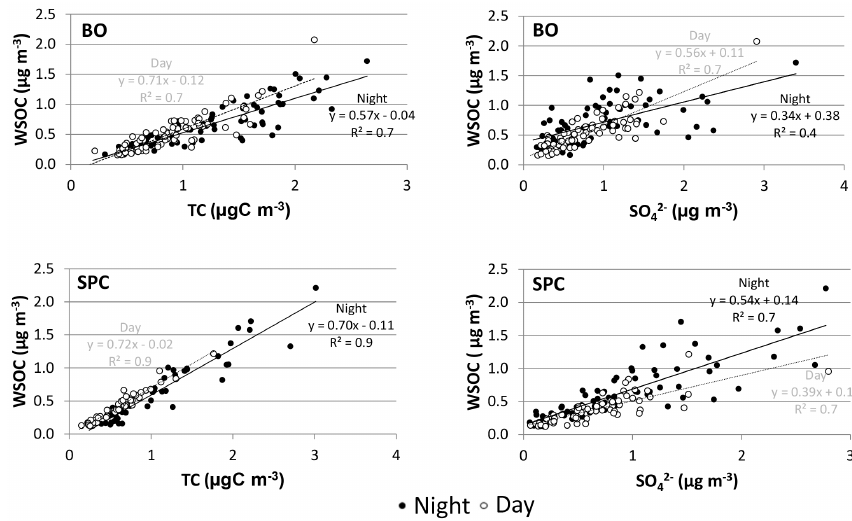
Figure 9. Linear regressions between WSOC and TC (left) and WSOC and SO 2 − 0.42µm and (3) 0.42–1.2µm in daytime and at night for BO (top) and SPC